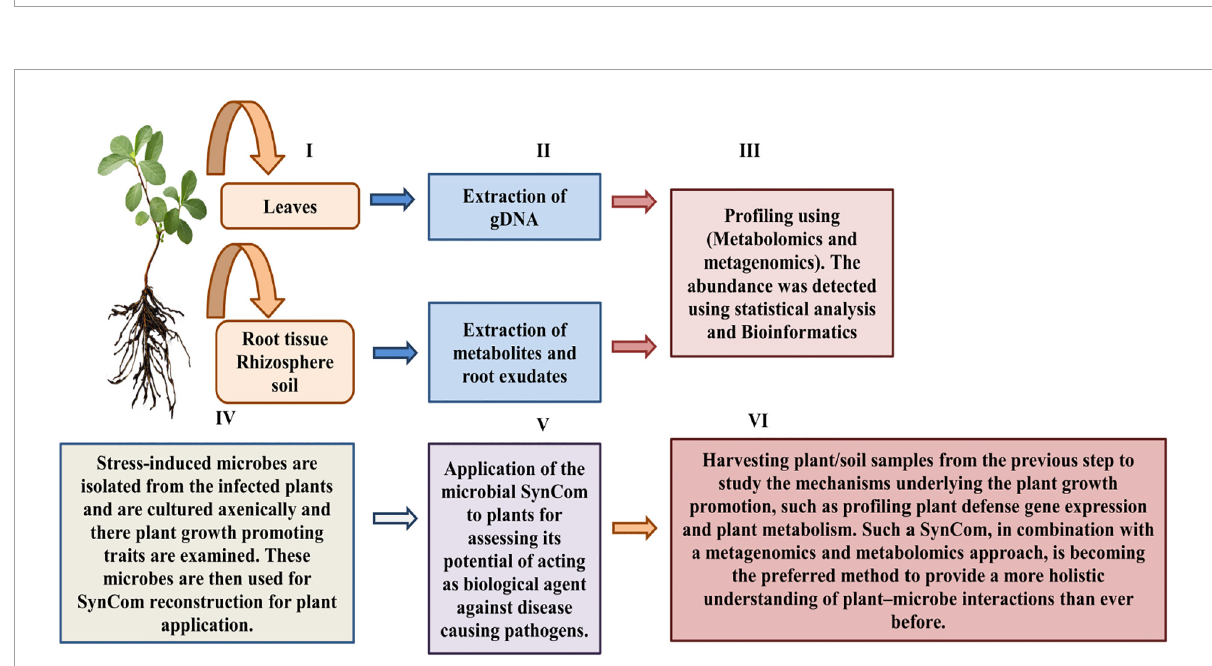
FIGURE5 Integrated approaches for studying plant-microbiome communication